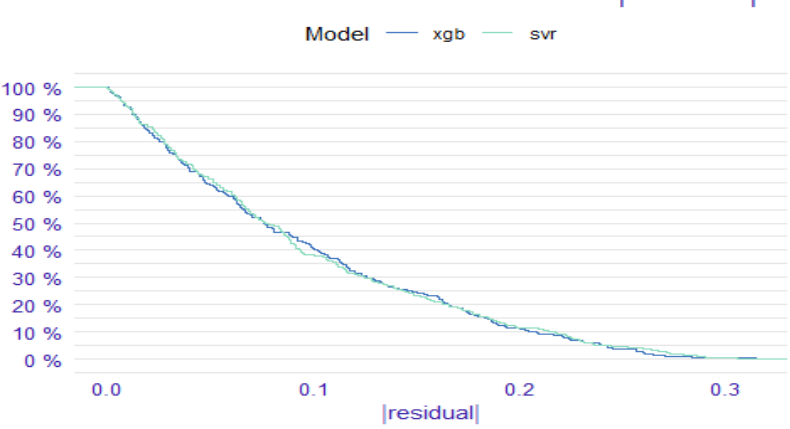
Figure 5. Reverse cumulative distribution of residuals during the pre-COVID-19 period.